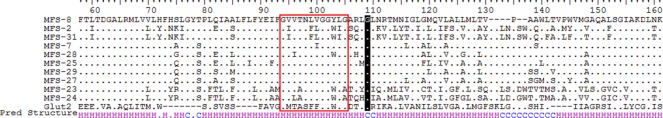
Partial sequence alignment of human liver Glut2 and MFS sub-cluster_2 (Fig. 1), along with secondary structure prediction (HHpred).Dots represent identical amino acid residues. There is 19% identity and 36% similarity of amino acids in this region of aligned sequences. Sequences of putative glycine zipper structures are within the box, followed by a putative functional glycine (shadowed). Bottom line of Pred Structure: H, helix structure; C, coil or loop structure.